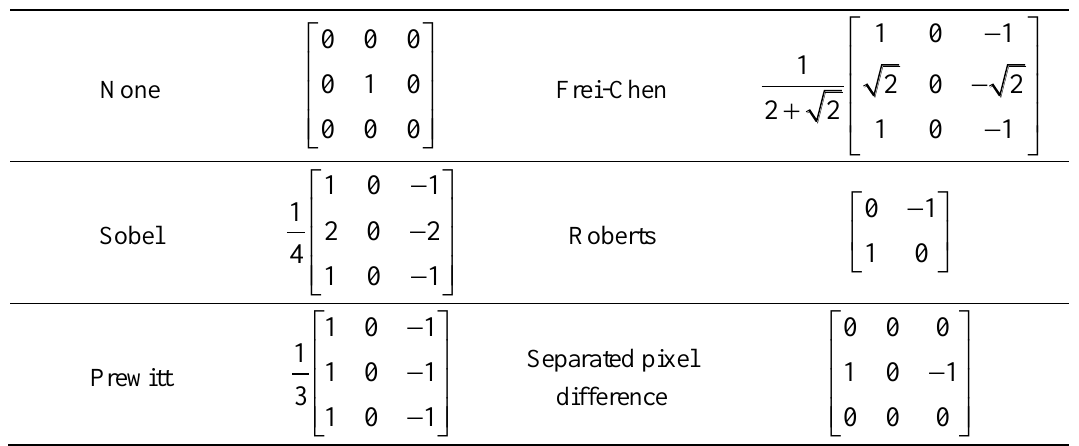
Table 2. List of tested sharpening filters. Only row gradient operators are shown, used column gradient operators were just transposed versions of the row